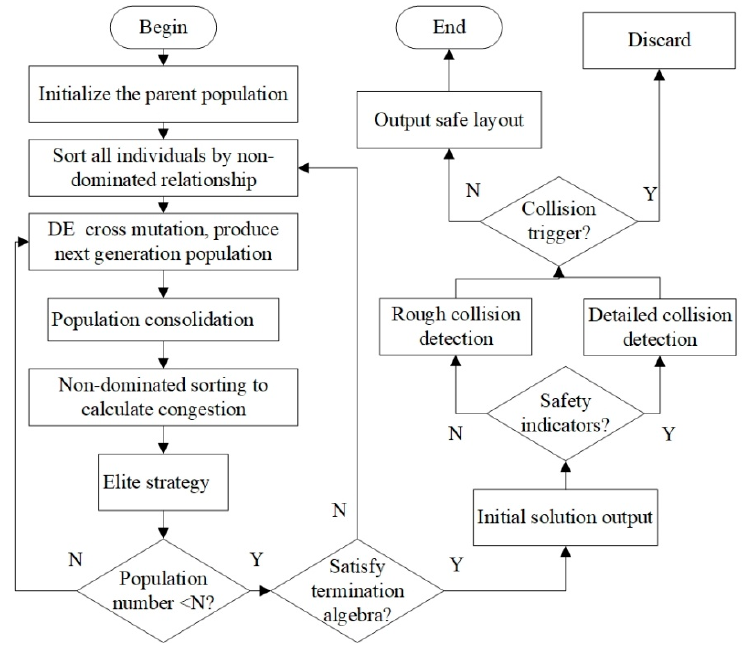
Figure 4. The procedure of the proposed SE-NSGA2.